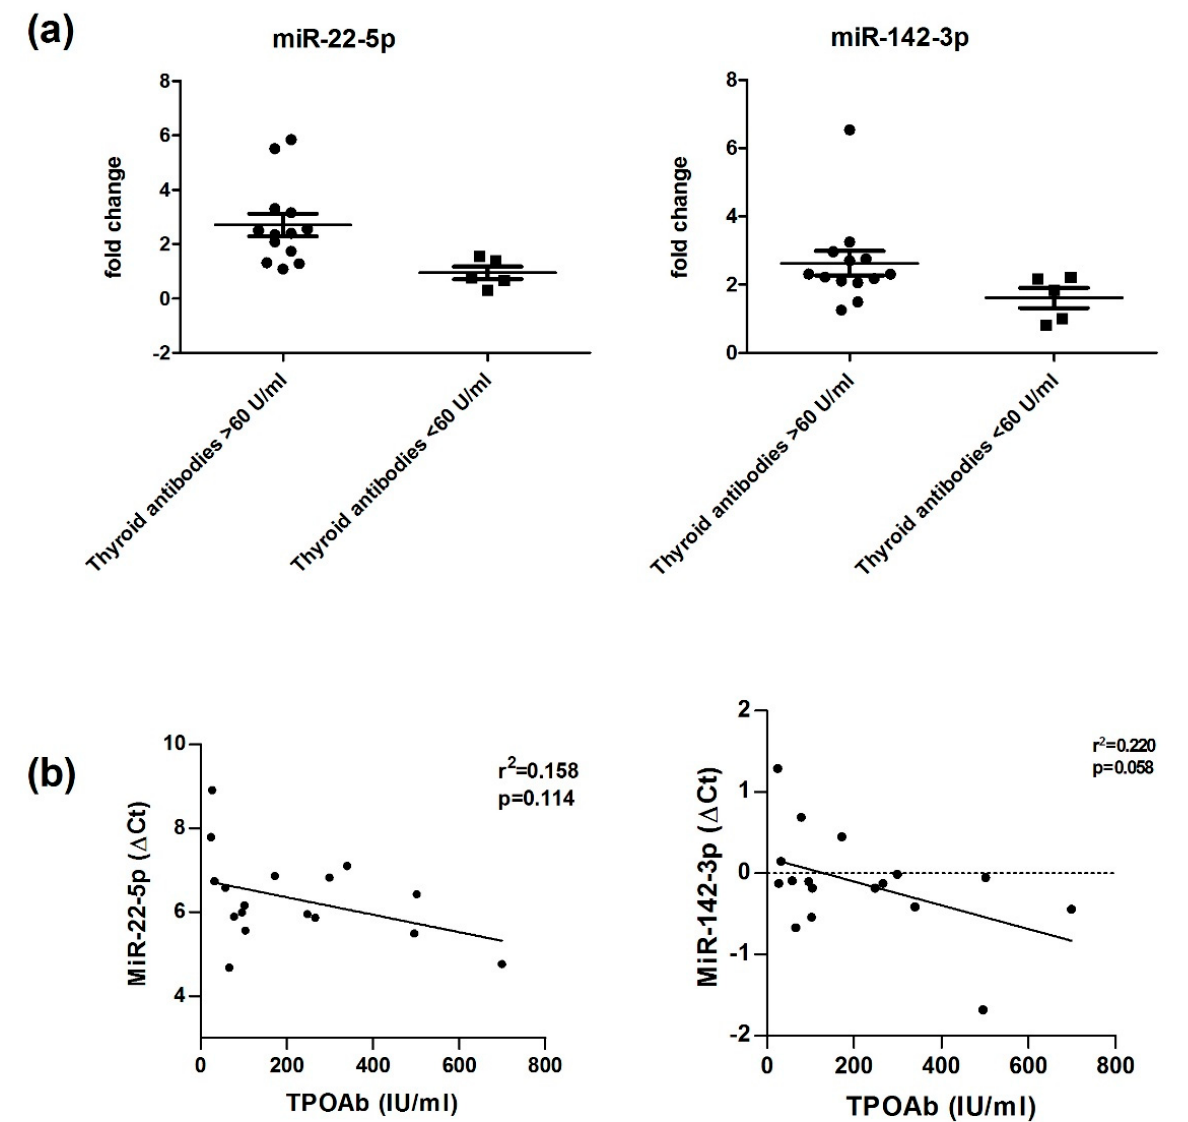
Figure 3. ( a ) Altered Expressions of miR-22-5p and miR-142-3p in serum of HT patients with higher levels of thyroid antibodies compared to HT patients with thyroid antibody levels <60 U/mL. Data are displayed as scatter plots, where each dot represents the ∆ Ct value of one HT patient.